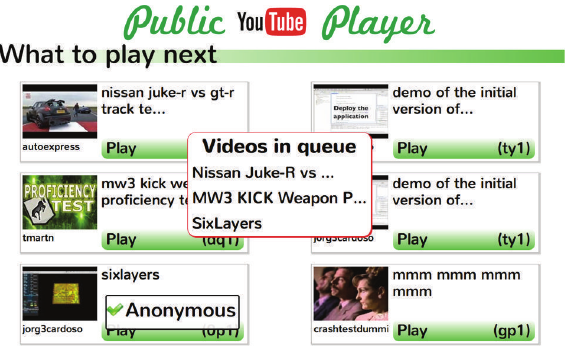
Figure 2: Widgets in the context of a public display